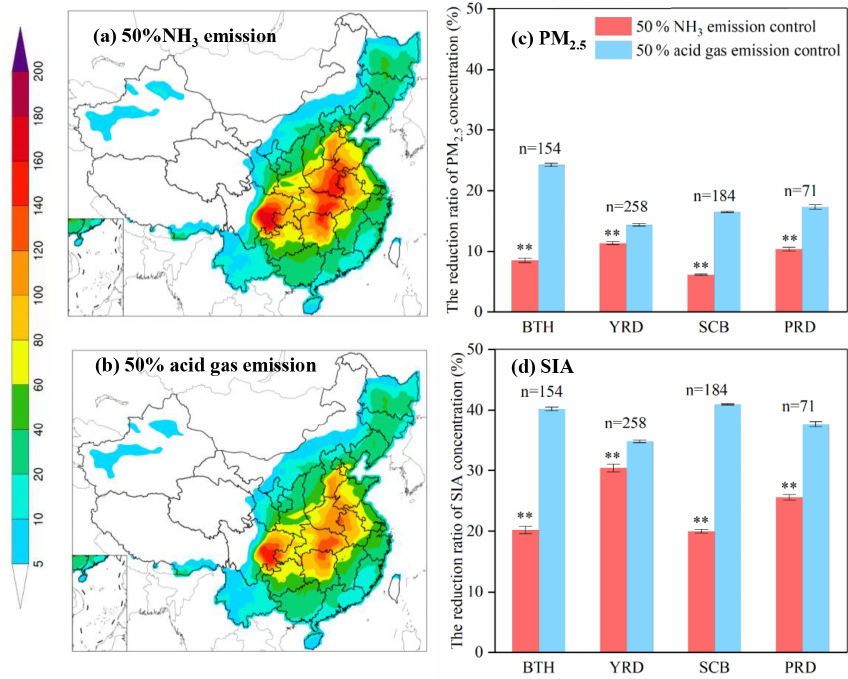
Figure 7. Left: the spatial distributions of simulated PM 2 . 5 concentrations (in µgm − 3 ) in January 2017 with (a) 50% reductions in am- monia (NH 3 ) emissions and (b) 50% reductions in acid gas (NO x and SO 2 ) emissions. Right: the % decreases in PM 2 . 5 (c) and SIA (d) concentrations for the simulations with versus without the NH 3 and acid gas emission reductions in four megacity clusters (BTH: Beijing– Tianjin–Hebei, YRD: Yangtze River Delta, SCB: Sichuan Basin, PRD: Pearl River Delta). ∗∗ denotes significant differences without and with 50% ammonia emission reductions ( P < 0 . 05). n is the number of calculated samples by grid extraction. Error bars are standard errors of means.